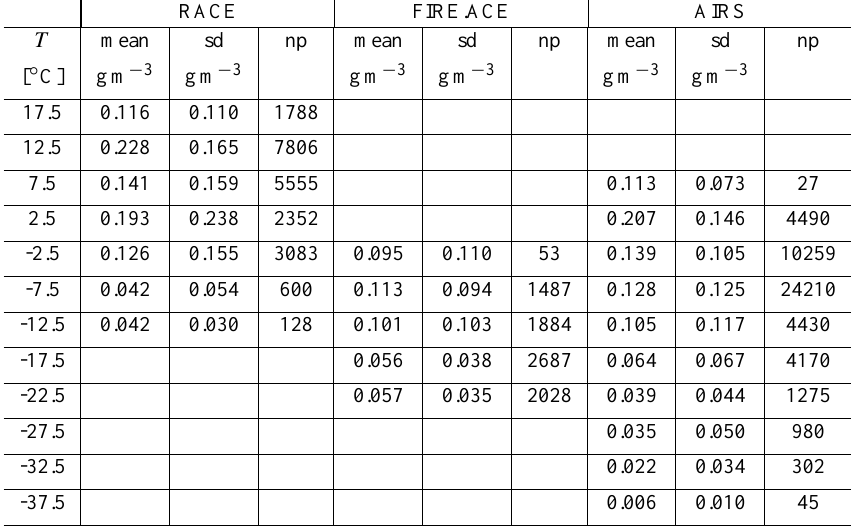
Table 1. Mean, standard deviation (sd), and number of points (np) used in the calculations for 1T = 5 ◦ C intervals for all projects RACE FIRE.ACE AIRS T mean